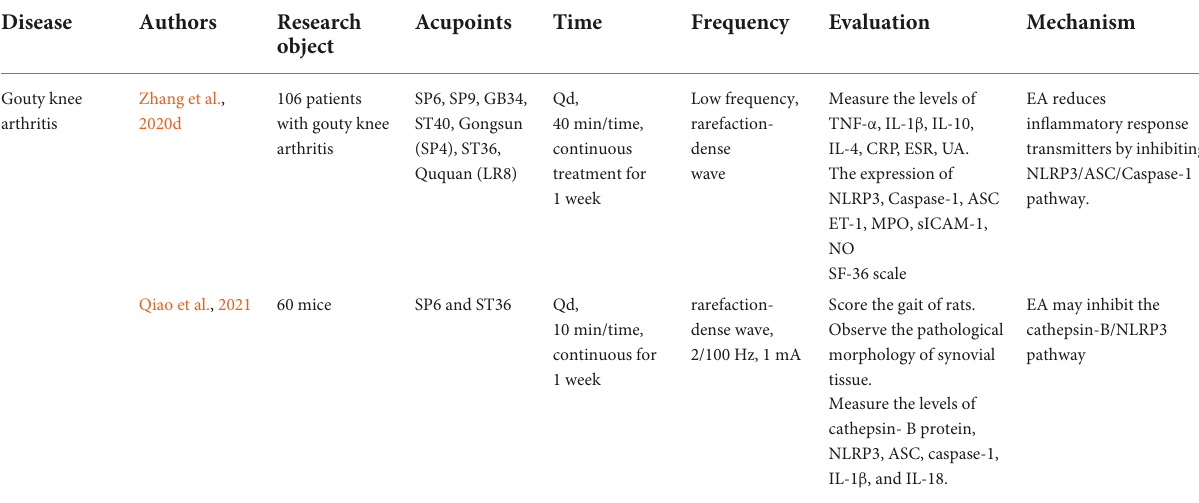
TABLE 5 Mechanism of electroacupuncture targeting NLRP3 inflammasome in the treatment of gouty knee arthritis.